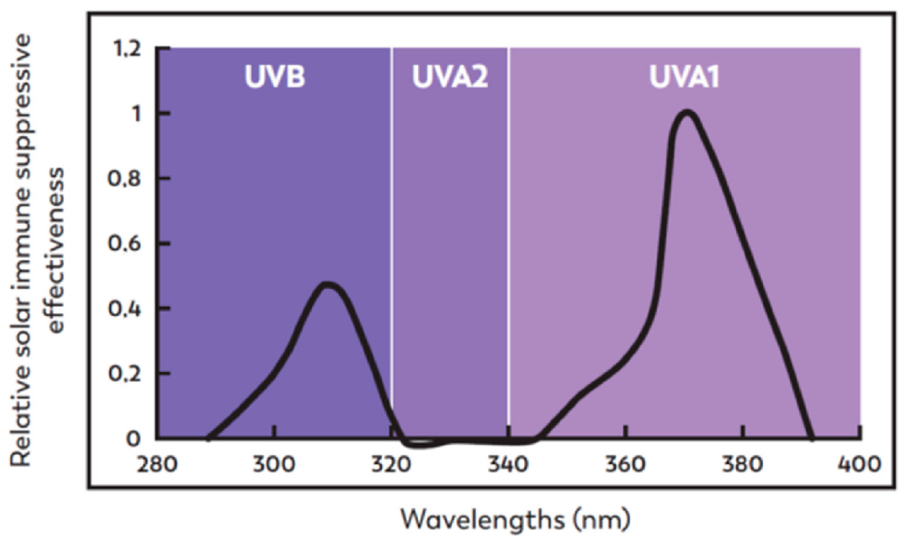
Figure 3. Solar effectiveness for immunosuppression in humans. Under natural daily moderate solar light exposure conditions, and taking into account the irradiance of the different UV domains, the graph shows that, apart from the well-known UVB contribution, UVA1 rays can have a predominant immunosuppressive effect. Adapted from [12] .